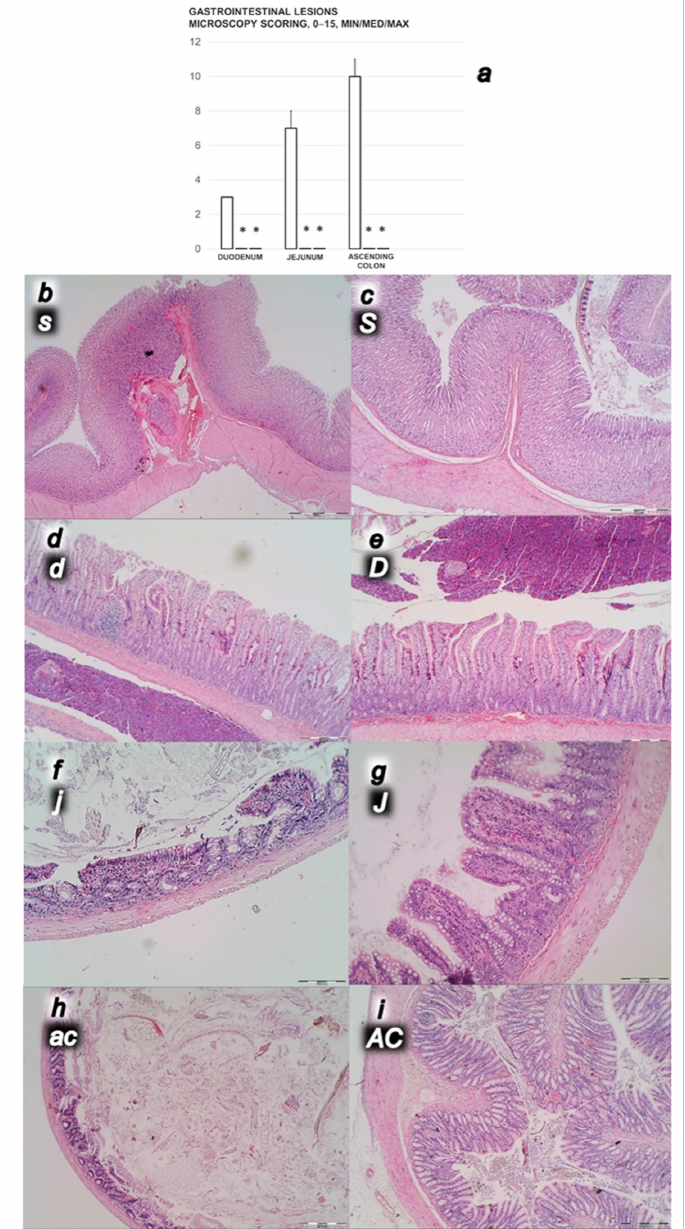
Figure 6. ( a ) Microscopy scoring of the lesions of the duodenum, jejunum and ascending colon (scored 0–15) ( a ) in the rats with ligated superior mesenteric vein at the end of the 30 min period following medication (BPC 157 10 µ g/kg (light gray bars), 10 ng/kg (dark gray bars); saline 5 mL/kg (white bars)) given intraperitoneally. Six rats/group/interval. * p < 0.05, at least vs. control. ( b – i ) Characteristic microscopy presentation of the affected gastrointestinal tract ( b – i , black letters, lesions specifically indicated with white letters, small letters (control), capitals (BPC 157), as follows: stomach ( s , S ), duodenum ( d , D ), jejunum ( j , J ), and ascending colon ( ac , AC )). Note from stomach ( b , c ) (hyperemia in controls ( b ), unlike BPC 157 ( c ) rats), duodenum ( d , e ), (blunt villi with discrete villi reduction and cryptal hyperplasia in controls ( d ), unlike BPC 157 rats ( e )), jejunum ( f , g ) (hyperemia and reduction of villi in controls ( f ), unlike BPC 157 rats ( g )) and ascending colon ( h , i ) (dilatation of lumen, reduction of crypts, hyperemia of lamina propria in controls ( h ), unlike BPC 157 rats ( i )). (HE; magnification × 20, scale bar 500 µ m ( b , c ); × 40, scale bar 200 µ m ( d – i